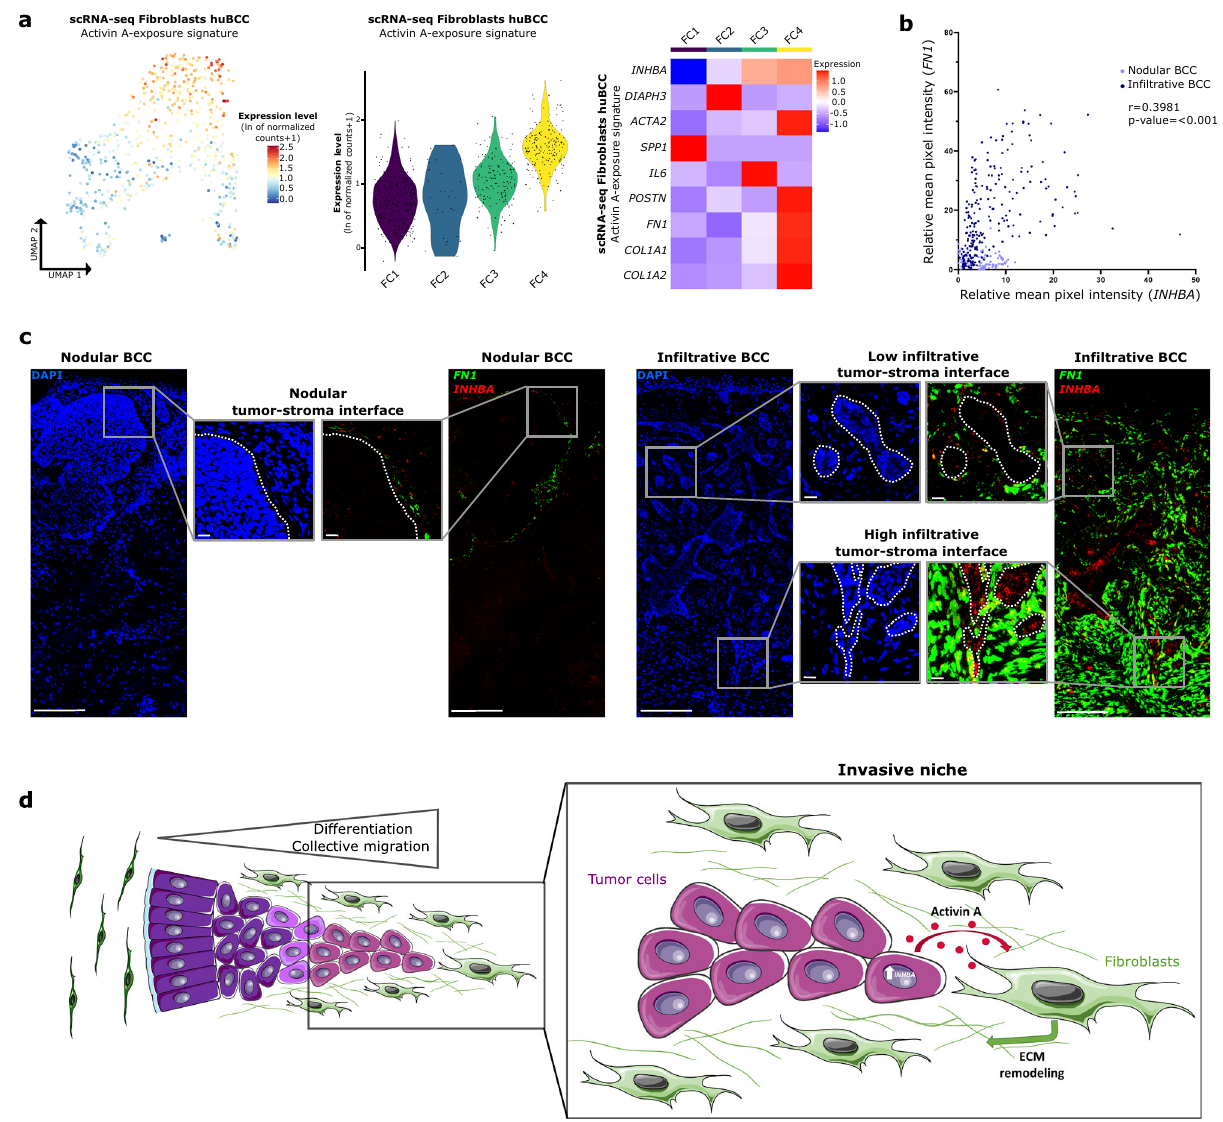
Fig. 7 | Activin A signals between spatially-connected in fi ltrative tumor cells and associated CAFs. a Average expression level of the signature resulting from Activin A exposure in the fi broblast subpopulations of the scRNA-seq dataset, represented as a color scale overlaid on the UMAP plot (left panel) and as violin plotsper ranked cluster (middle panel).Right panel shows the heatmapofaverage expression level of genes present in the signature in ranked clusters of the fi bro- blast subpopulations. b Correlation analysis between tumor INHBA and adjacent stromal FN1 relativeintensitiesinnodular( N =4)andin fi ltrative( N =8)BCCs( n ≥ 10 regions/sample). R coef fi cient and p value were calculated by the Spearman cor- relation test and a two-sided statistical signi fi cance test, respectively. c Representative scan images of nodular and in fi ltrative BCC sections stained with